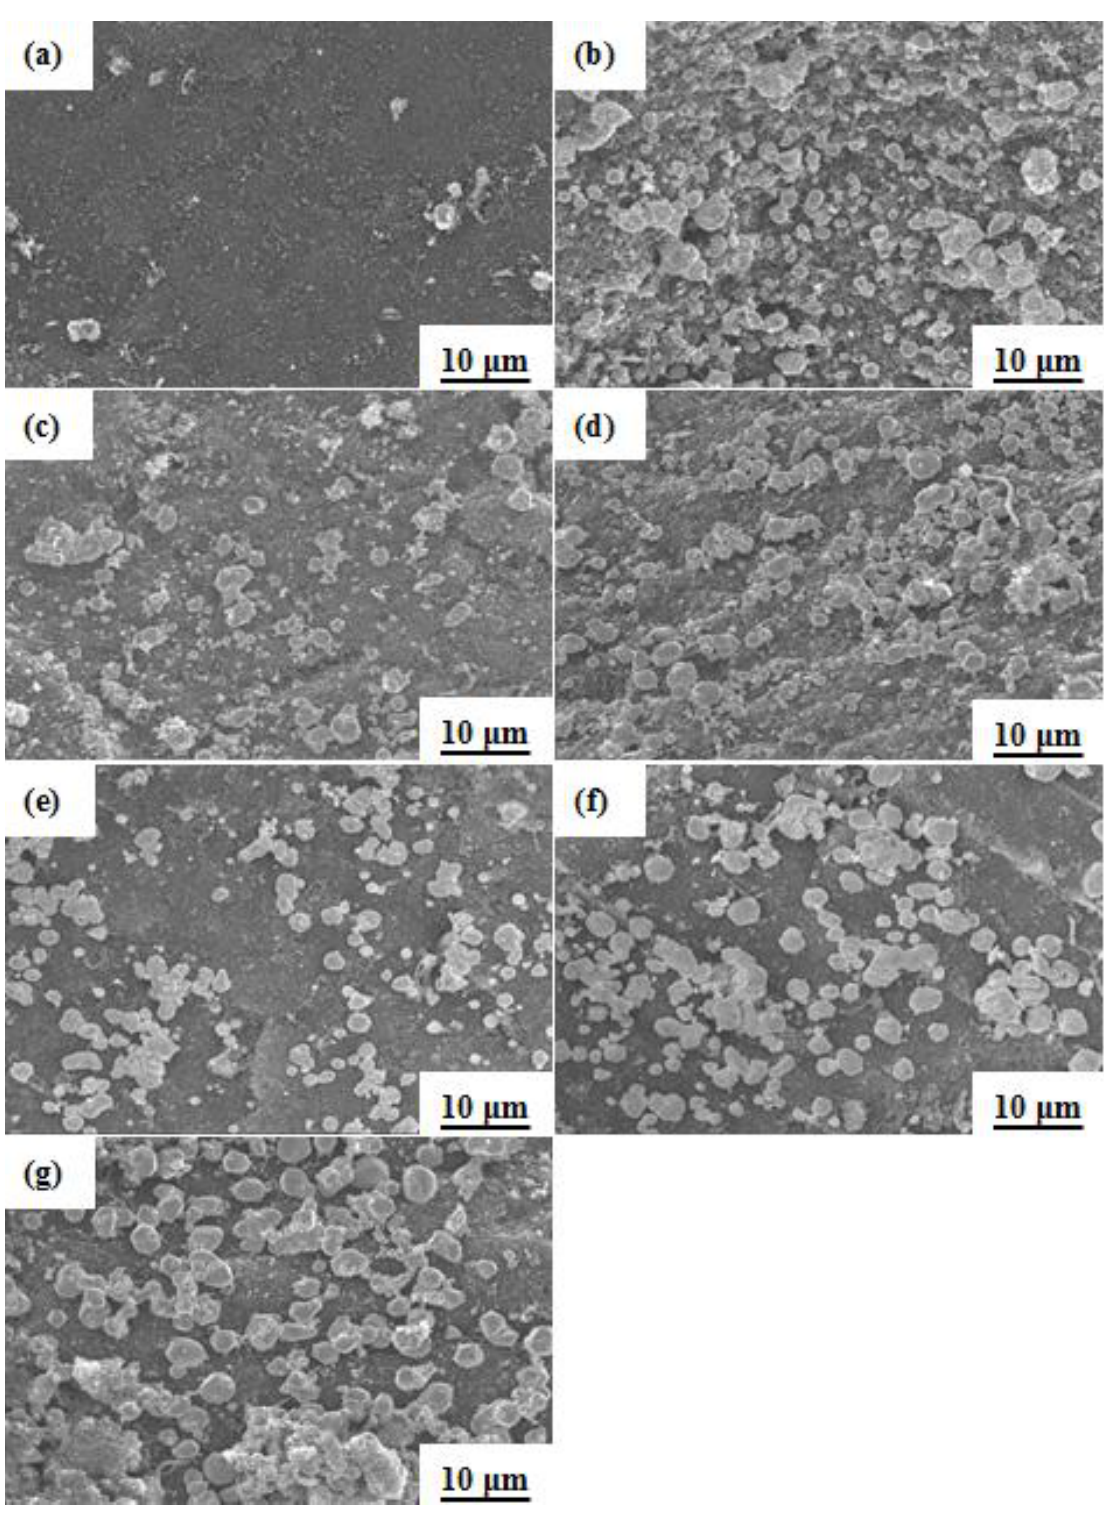
Figure 1. Scanning electron microscopy (SEM) images of Ag/bamboo charcoal (BC) for different reduction temperatures for 2 h: ( a ) blank; ( b ) 100 °C; ( c ) 120 °C; ( d ) 130 °C; ( e ) 140 °C; ( f ) 150 °C; ( g ) 160